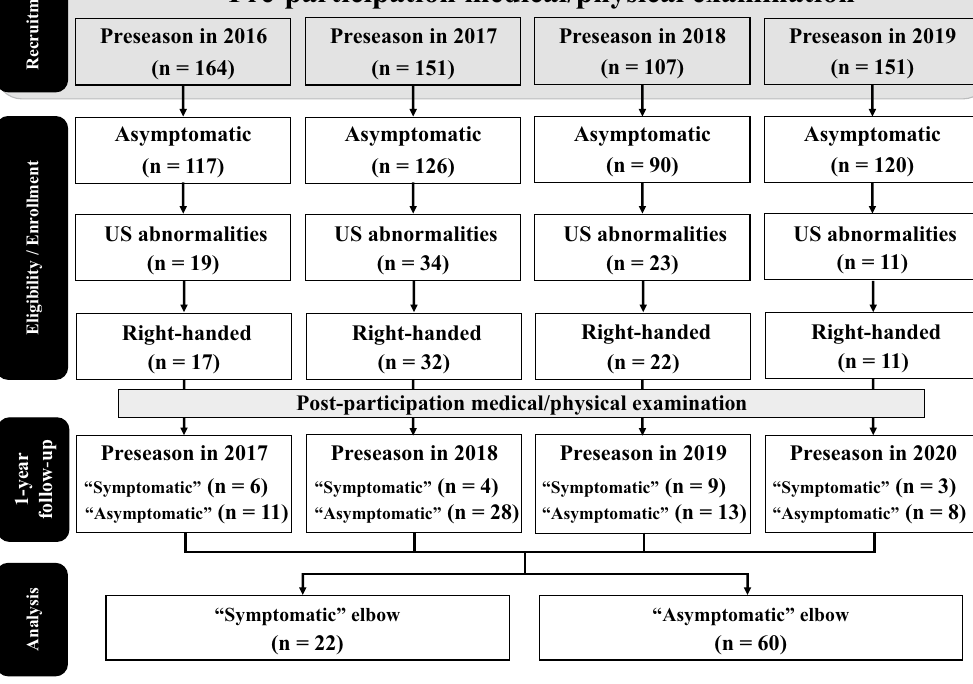
Figure 1. Flow chart of the players included in this